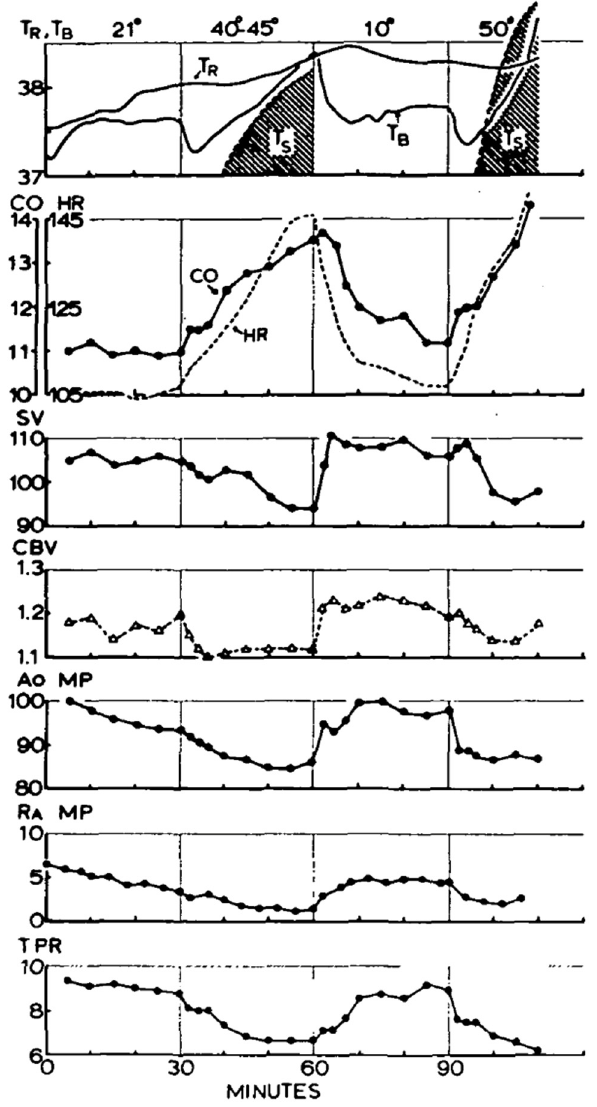
Figure 4. Demonstration of the impact of skin warming on skin temperature (T s ), rectal temperature (T R ),blood temperature from right atrium (T B ), total peripheral resistance (TPR), right atrial mean pressure (R A MP), aortic mean pressure (AoMP), central blood volume (CBV), stroke volume (SV), and heart rate (HR) and cardiac output (CO). Image from [45 ].